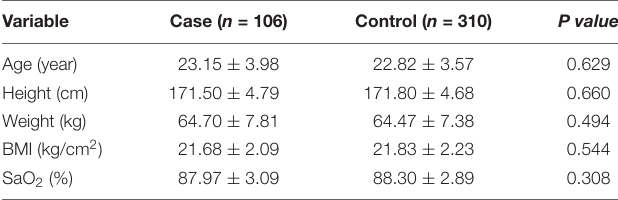
TABLE 1 | Characteristics of the